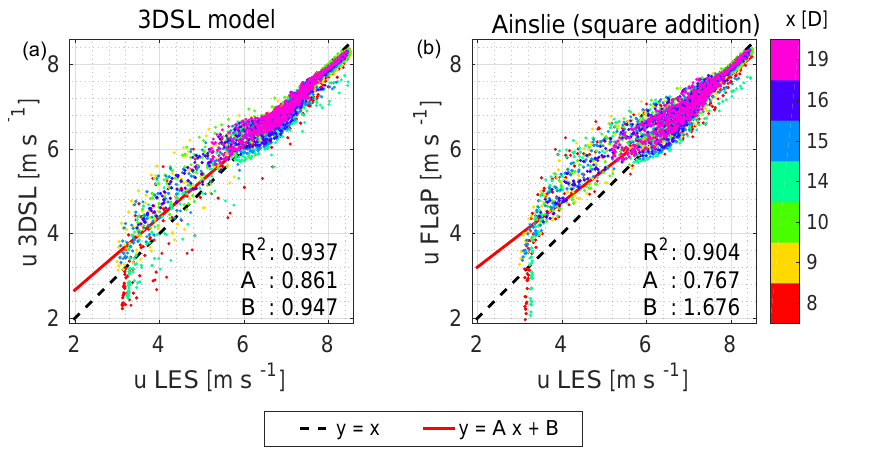
Figure 12. Test case 4 (multiple wakes with a 1.5 D lateral separation). Scatter plot and corresponding regression line of the wind speed derived from the 3DSL model (a) and from the FLaP wake simulations in relation to the reference wind field calculated with large-eddy simulations